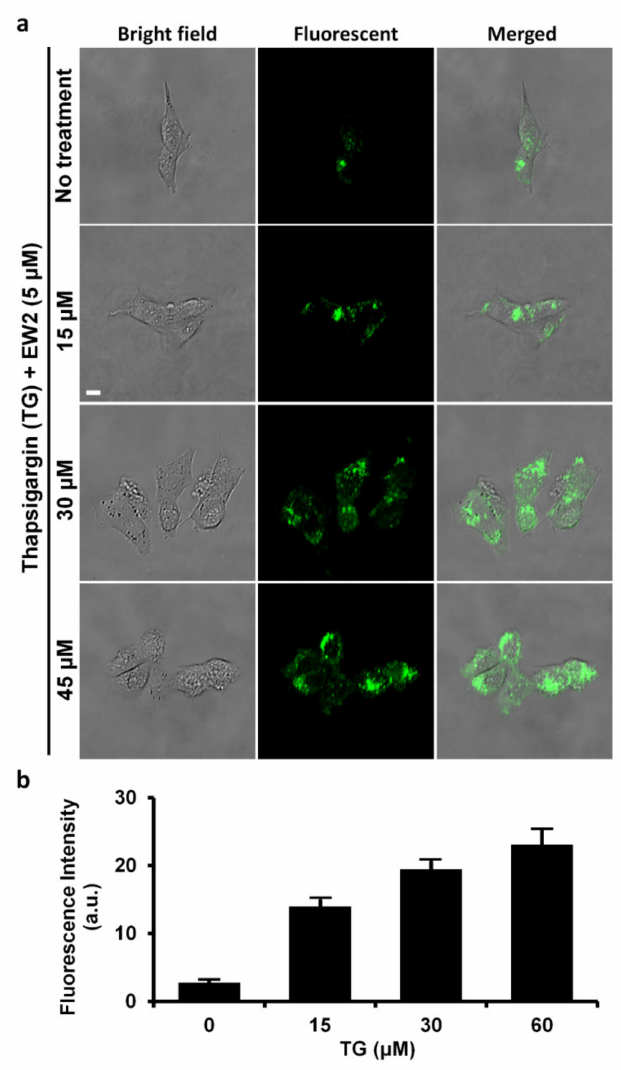
Figure 6. Fluorescent images of endogenous FA in MCF7 cells using probe EW2. Cells were cultured with TG (0, 15, 30, 45 µ M) for 30 min and then 5 µ M EW2. ( a ) Bright-field and fluorescence images of cells, and merged images. ( b ) Quantified mean fluorescence intensities of cells in the green channel: λ ex = 470 nm, λ em = 500–550 nm. Scale bar = 10 µ